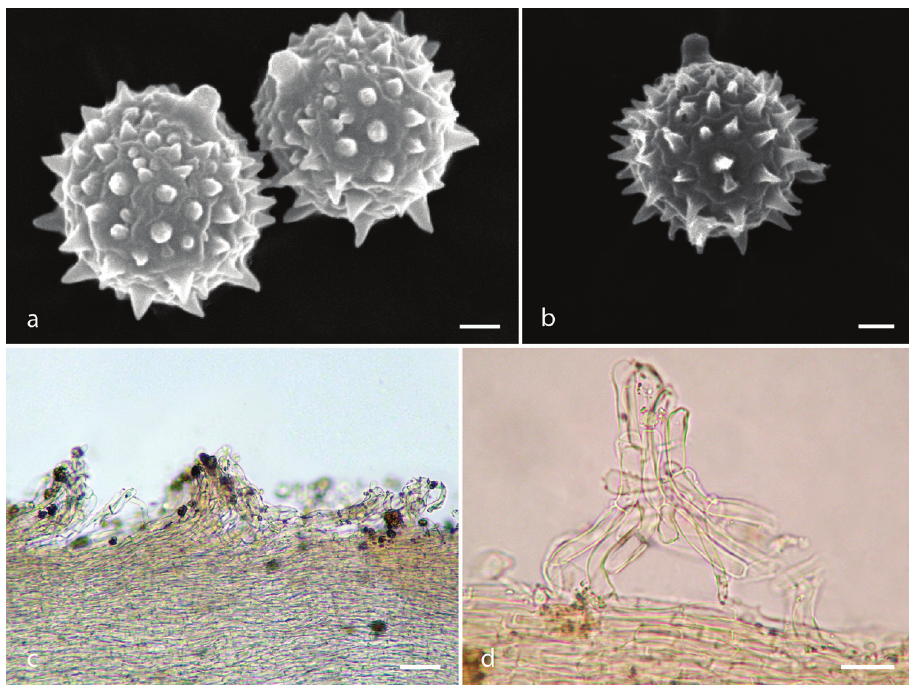
Figure 7. Laccaria trichodermophora , a–b basidiospores under SEM c–d pileipellis a, c–d Montoya 4393 b Bandala 4282. Scale bars: 1 µm ( a–b ); 50 µm ( c ); 25 µm ( d